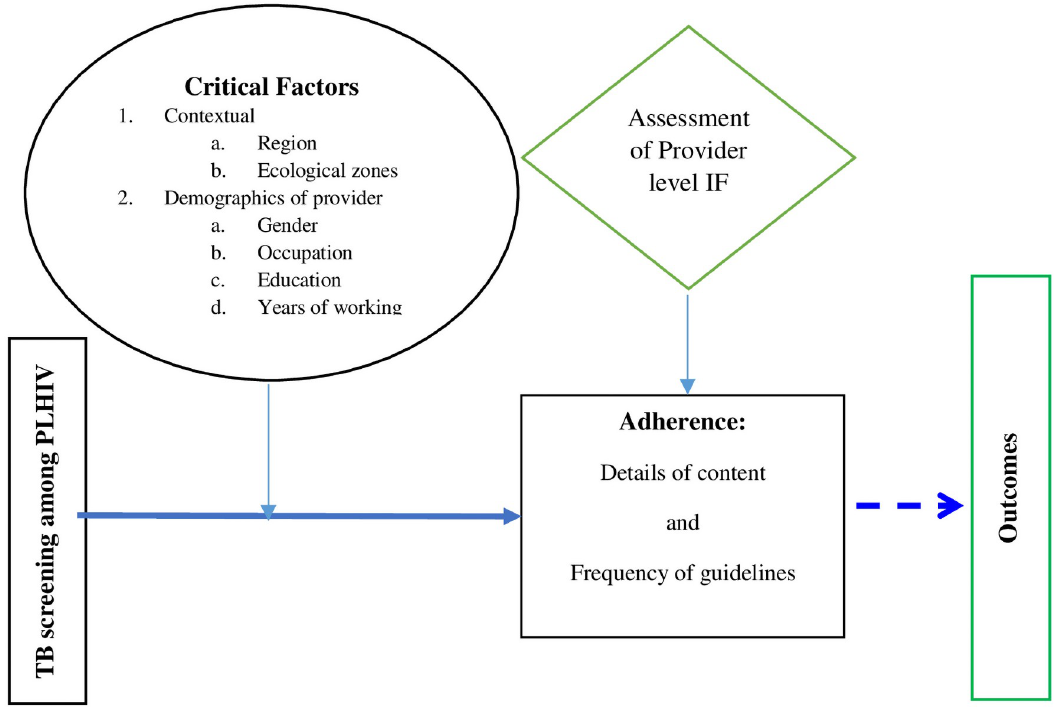
Fig 1. A conceptual framework for provider level IF to TB screening at HIV clinics in Ghana: Adapted from CFIF by Carroll et al., 2007.